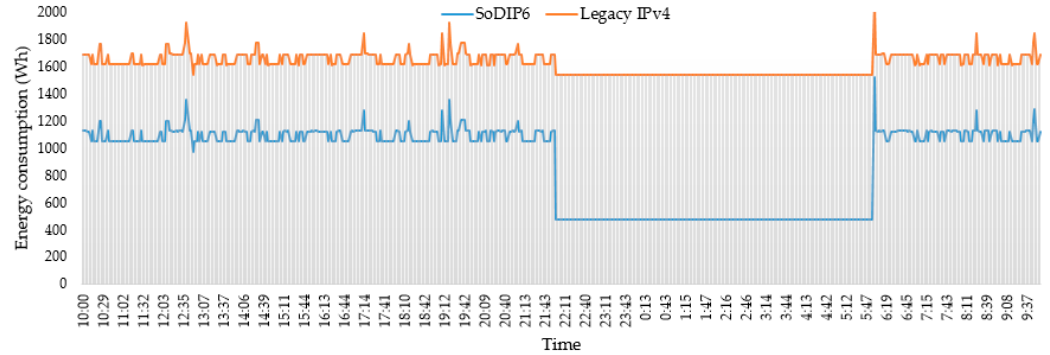
Figure 4. Pattern of total energy consumption by switches and customer premise equipment (CPE) in the legacy IPv4 and the software defined IPv6 (SoDIP6) network.